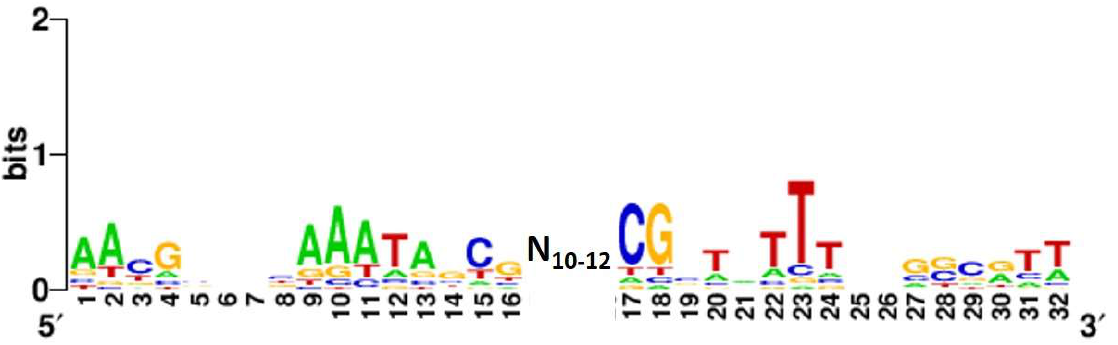
Figure 2. Consensus sequence of the FlhDC-box. Sequences of all the probes with high levels of FlhDC binding were analyzed using MEME (https://meme-suite.org/meme/ (accessed on 1 December 2022)) (see Table 1). WEBLOGO (http://weblogo.berkeley.edu/logo.cgi (accessed on 1 December 2022)) was used to perform matrix construction.